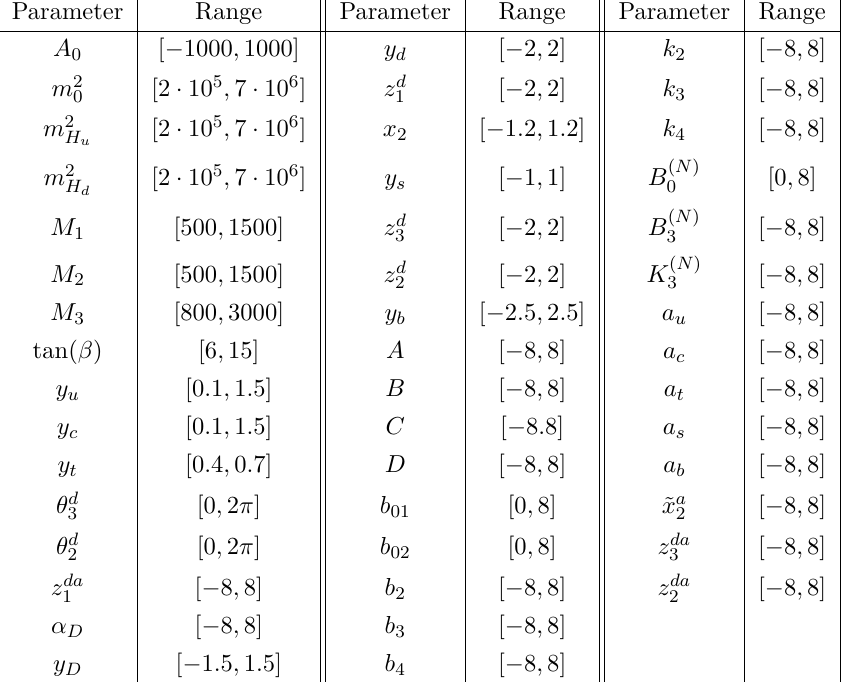
Table 2 . GUT scale input parameters for the model and their scanning range. For all parameters, the step size for a Markov chain iteration is given as 0.5% of the total range length of the allowed values. This step size was procured by trial and error in order to balance scan efficiency and a search of the parameter space. In addition, we set a fixed value for the following parameters: sign( µ ) = − 1 ; and λ = 0 . 22 and M = 2 · 10 16 which enters as parametrization of Yukawa, trilinear and mass GUT matrices as stated in eqs. (2.19), (2.20) and